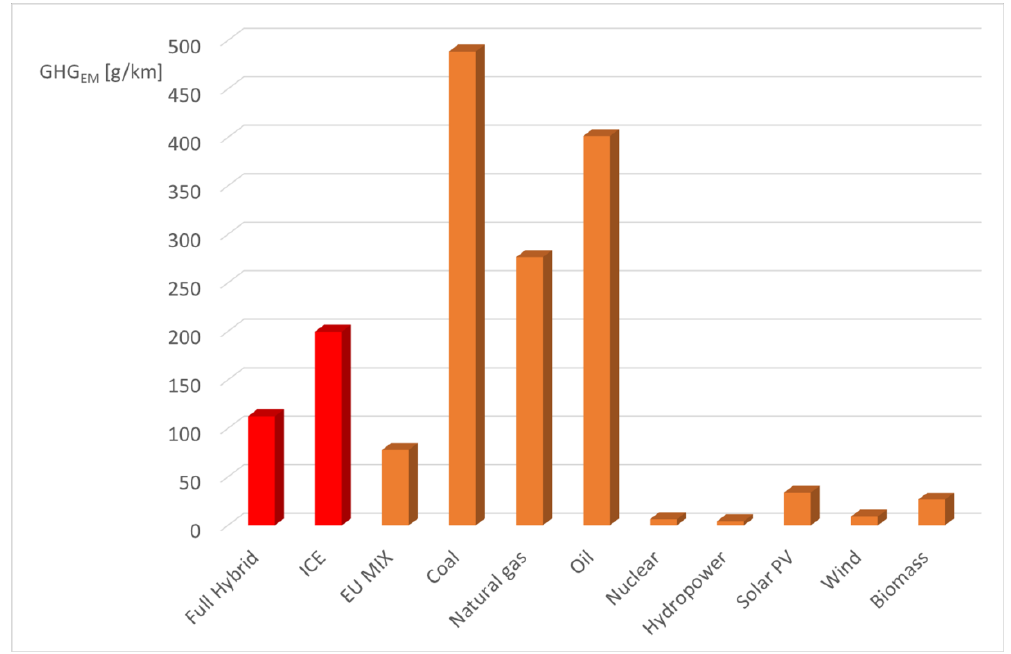
Figure 12. GHG emissions for the electricity production for different sources.